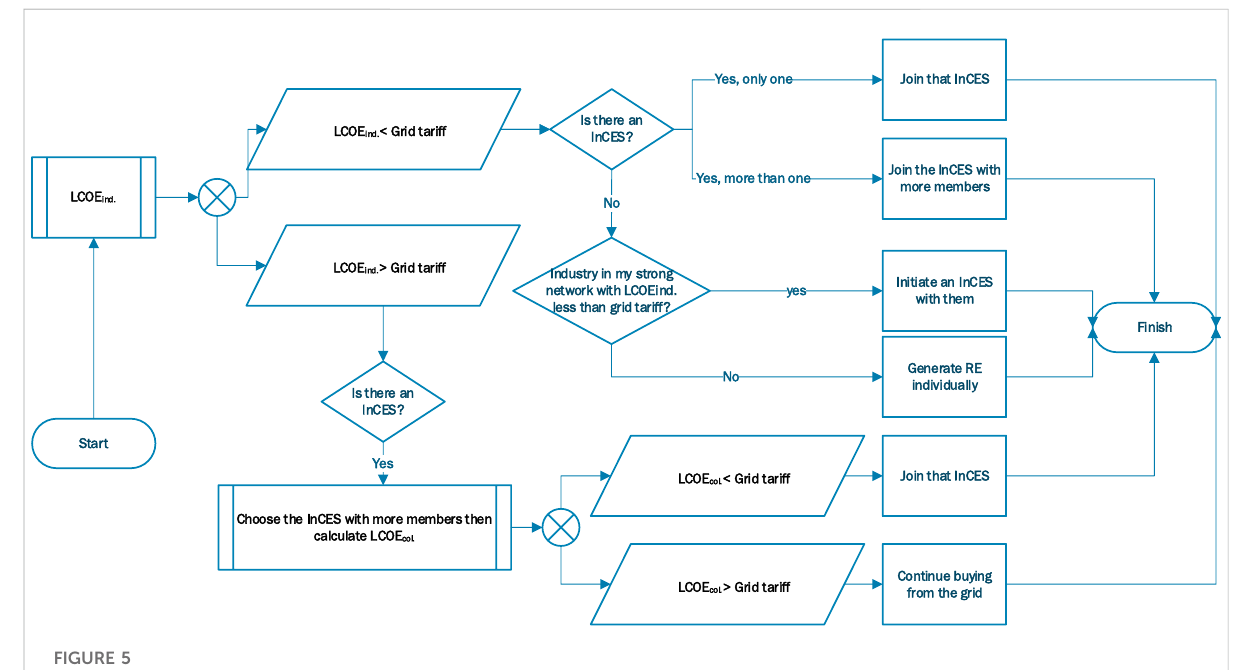
FIGURE 5 Flowchart of an industry joining/establishing an InCES or Exiting